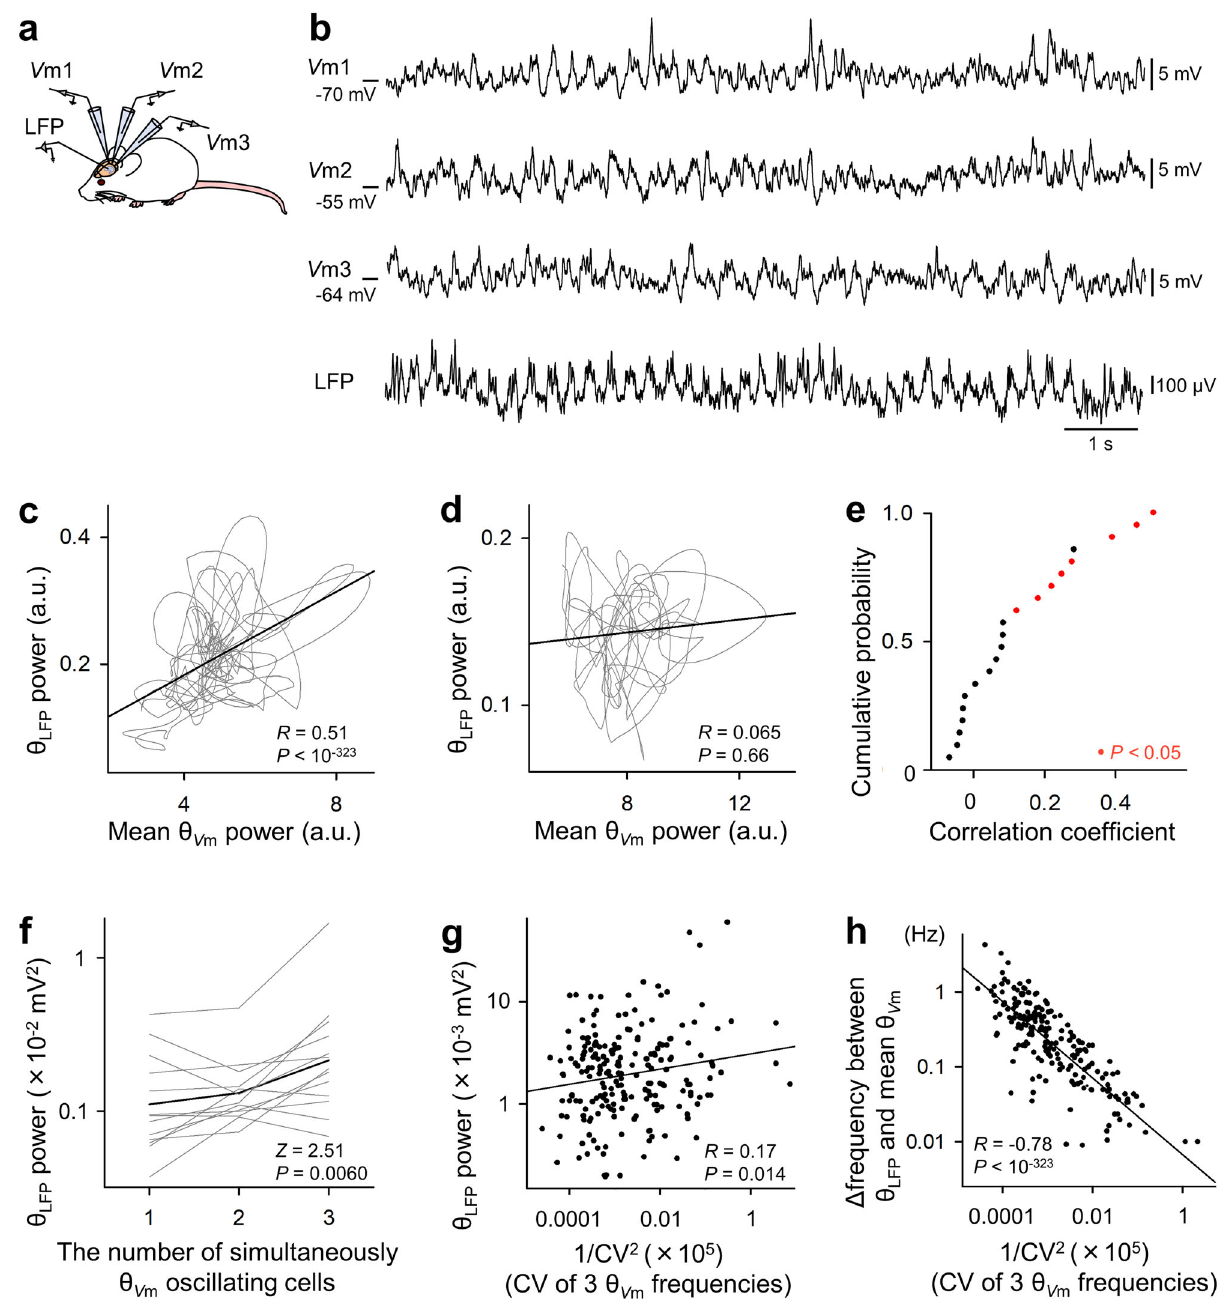
Fig. 4 Stronger correlations of θ LFP for more correlated θ V m s. a Schematic illustration of simultaneous recordings of LFPs and V ms of three CA1 pyramidal cells ( V m1, V m2, and V m3). b Representative raw traces of simultaneously recorded LFPs and V ms of three CA1 pyramidal cells. c , d The θ LFP power during a 1-s segment plotted against the geometric mean of the θ V m powers in three cells as a function of time. The triple recording in c exhibited a signi fi cant positive correlation ( R = 0.51, P < 10 − 323 , t -test for correlation coef fi cients, n = 740 segments), whereas the dataset in d did not ( R = 0.065, P = 0.66, n = 470 segments). The black lines indicate the lines of best fi t based on least-squares regression. e Cumulative probability distribution of the pairwise correlation coef fi cients between θ LFP powers and the mean θ V m powers of three cells for all 21 datasets. Each red dot indicates a dataset with a signi fi cant positive correlation. f The θ LFP power increased as a function of the number of cells that simultaneously emitted θ V m s. Each gray line indicates a single dataset, and the black line represents the mean. P = 0.0060, Z = 2.51, Jonckheere trend test, n = 13 datasets. g The θ LFP powers were positively correlated with the similarity of three θ V m frequencies. The similarity was de fi ned as the squared inverse of the coef fi cients of variance (1/CV 2 ) of three θ frequencies for co- θ periods during which LFPs and three cells simultaneously exhibited θ oscillations. Each dot indicates a single co- θ period. R = 0.17, P = 0.014, t -test for correlation coef fi cients, n = 206 co- θ periods from 13 cell triplets. The black line indicates the line of best fi t based on least-squares regression. h The difference between the θ LFP frequency and the geometric mean of three θ V m frequencies was negatively correlated with the similarity of three θ V m frequencies. Each dot indicates a single dataset. R = − 0.78, P < 10 − 323 , n = 206 co- θ periods from 13 cell triplets. The black line indicates the line of best fi t based on least-squares